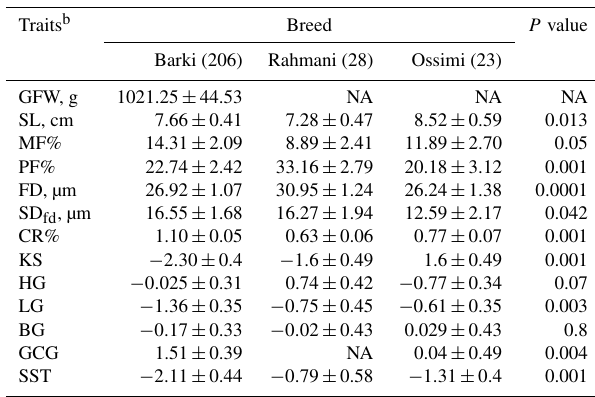
Table 2. Genotypic and allelic frequencies of the amplified region of the ovine KAP22-1 in Egyptian sheep breeds.